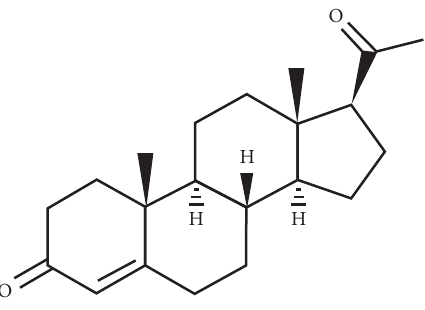
Figure 1: Chemical structure of